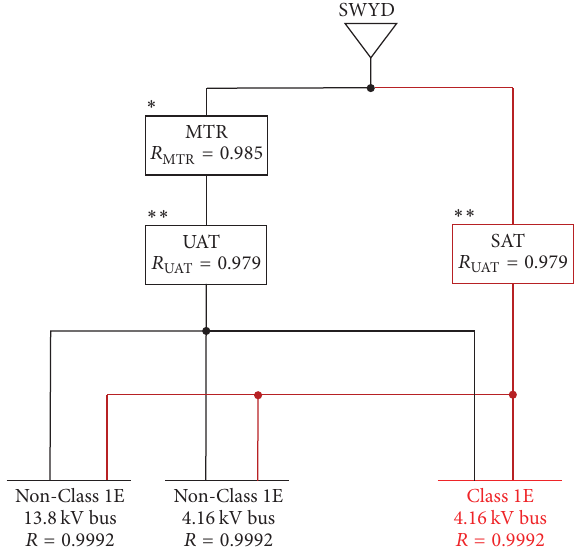
Figure 6: Reliability of existing electric power system. ∗ Two- winding transformer. ∗∗ Three-winding